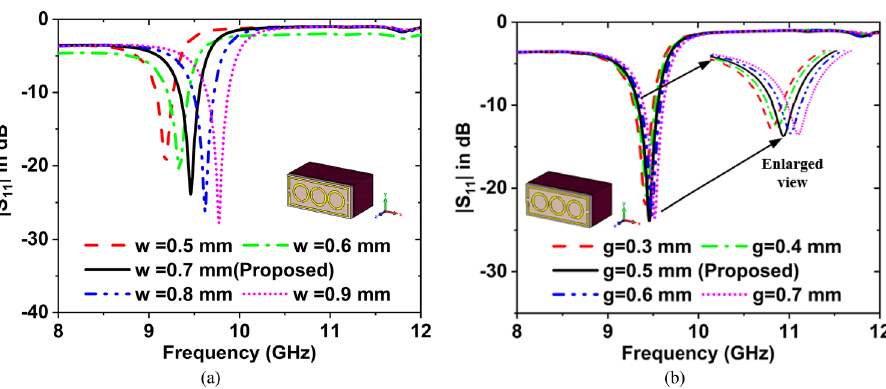
Figure 8. Effect on the resonance frequency for the change of ( a ) resonator width, and ( b ) resonator split